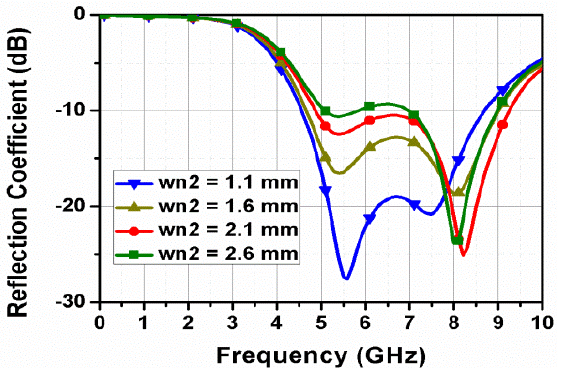
Figure 11. Reflection coefficients of the antennas in intermediate steps of the antenna linked with port 10.